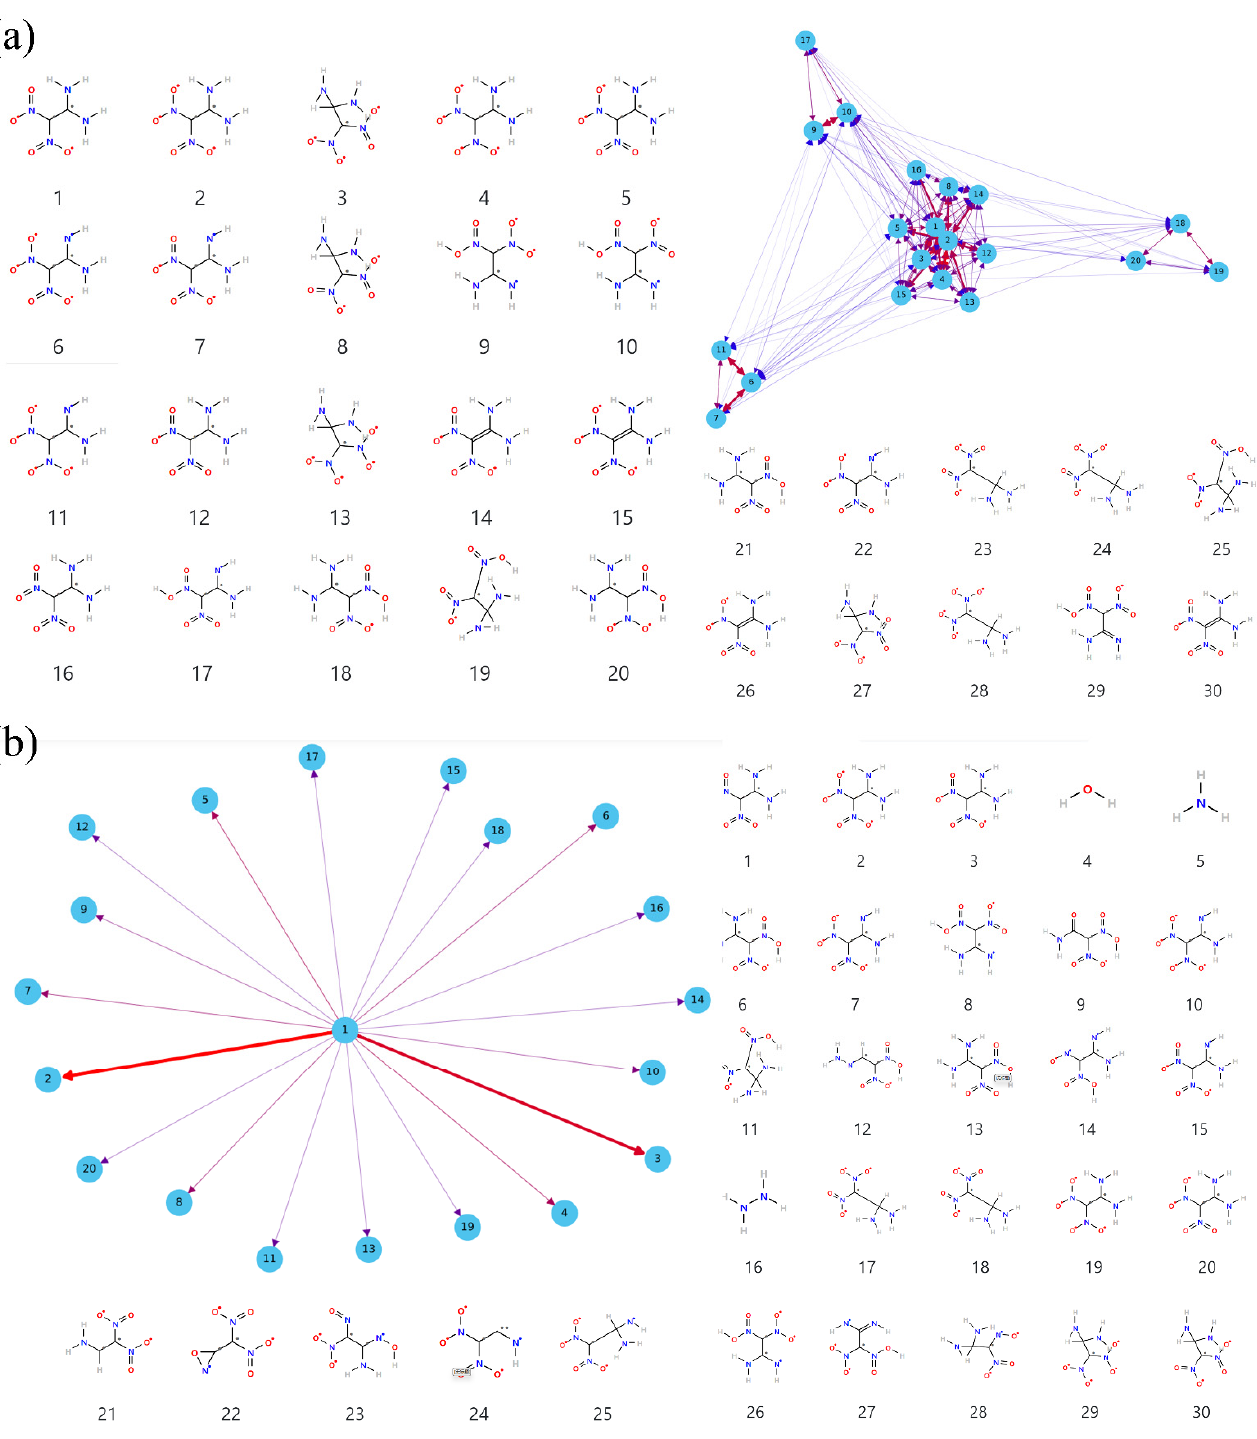
Figure 7. The initial reaction network for FOX-7 at 2000 K: ( a ) the network without HMM filtering; ( b ) the network with HMM.